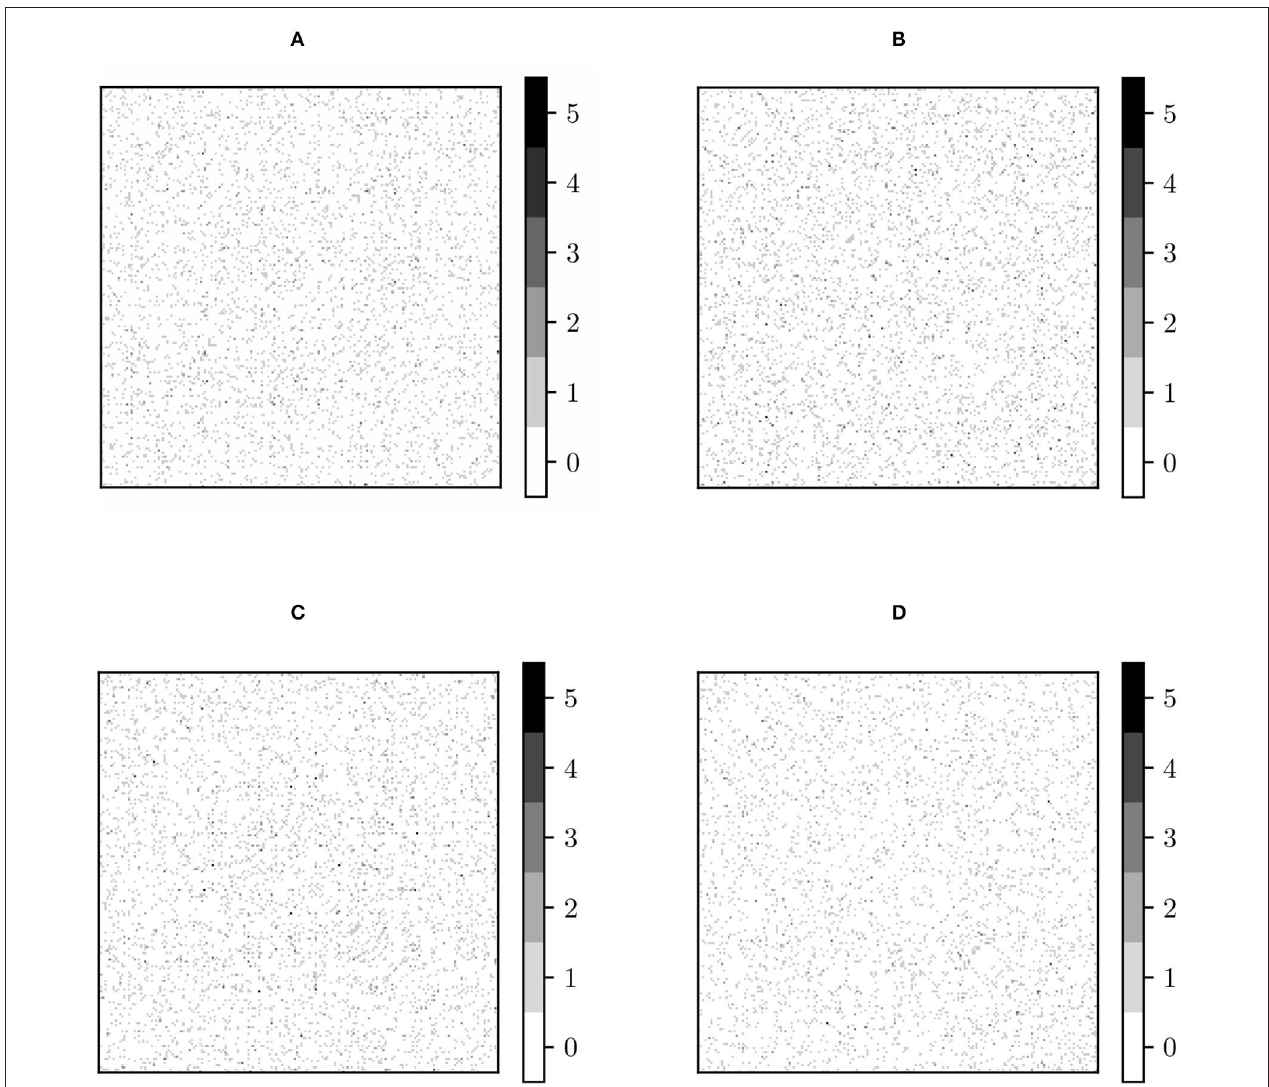
FIGURE 6 | Frequency matrices F ij obtained by performing 100 permutation experiments with the same randomly pooled subjects, binarizing each experiment’s p-value matrix at p < 0.001 and summing these resulting matrices for (A) original functional connectivity (FC) matrices; (B) FC matrices transformed under matrix whitening; (C) FC matrices transformed under Rigid Log-Euclidean Translation (RLET) to the global mean 6 ; (D) FC matrices transformed under RLET to the identity